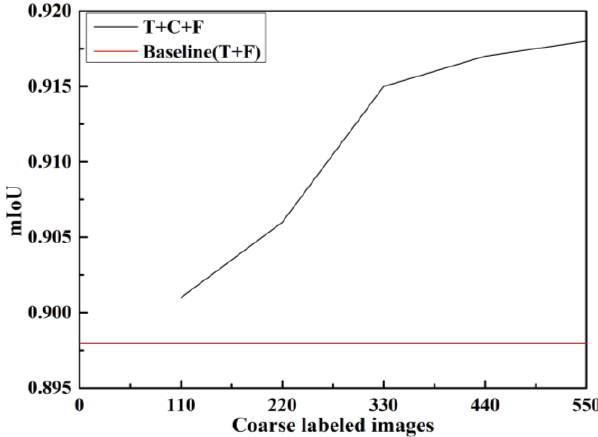
Figure 9. The change of mIoU with the number of CA images.